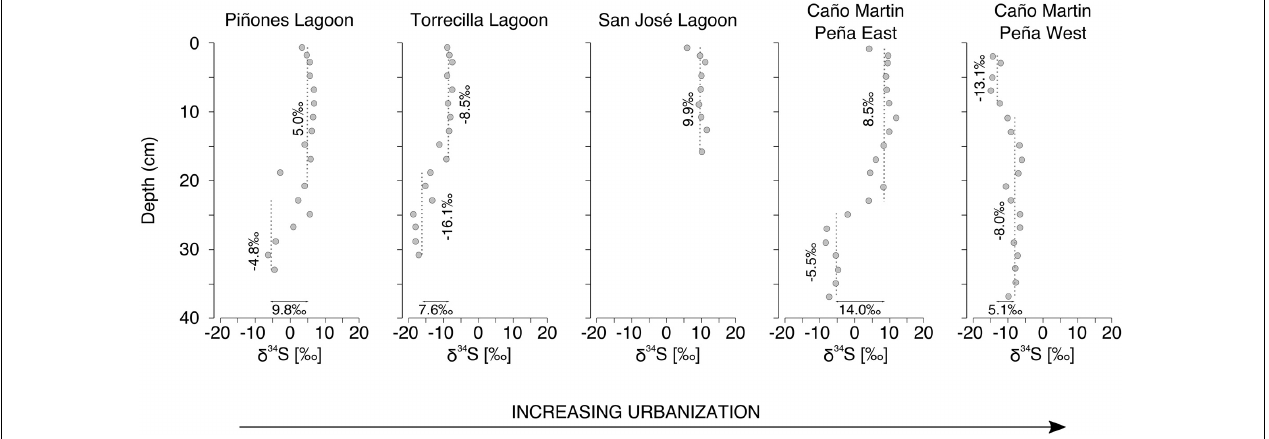
least flushing (Piñones, Martin Peña East) had the highest values,